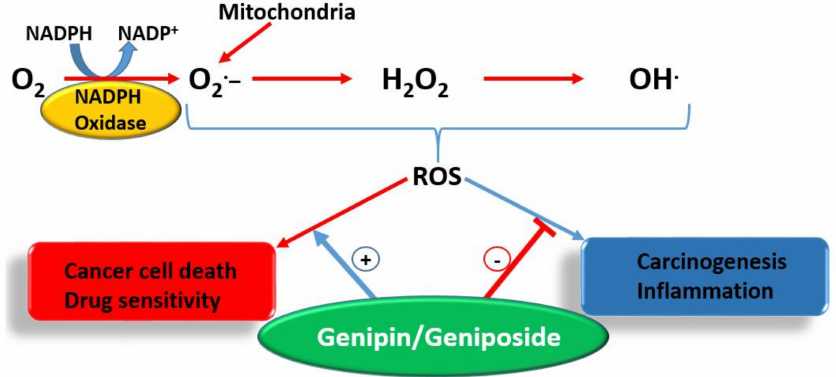
Figure 5. The dual effect of genipin/geniposide on ROS. The plus (+) sign indicates potentiation while minus ( − ) sign indicates